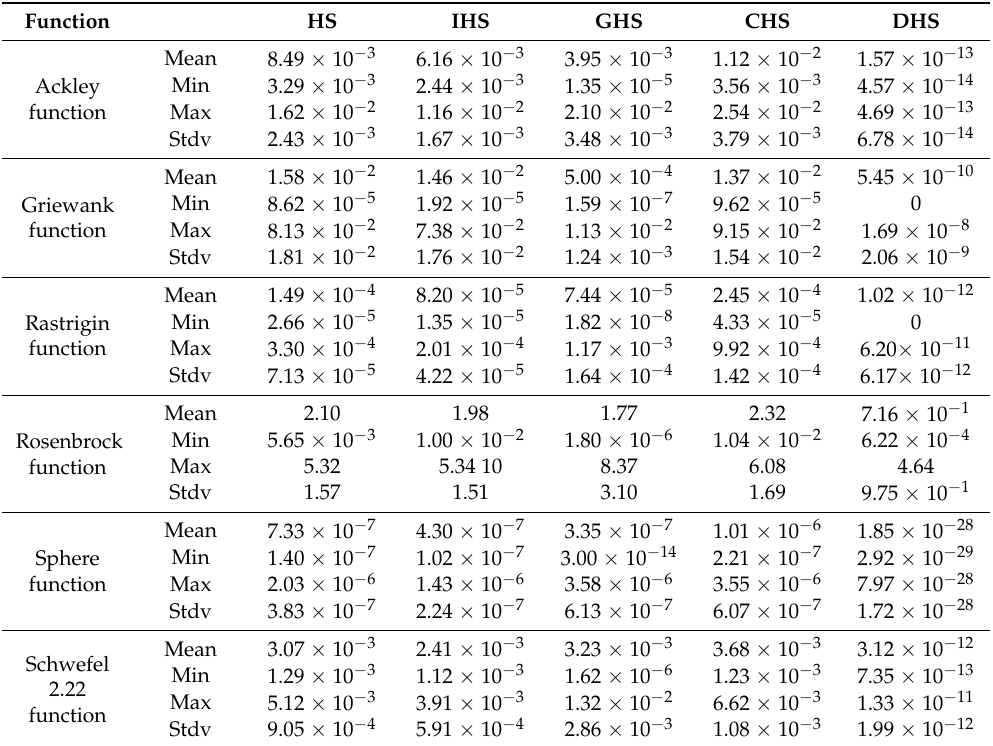
Table 3. Errors of test results of the algorithms.